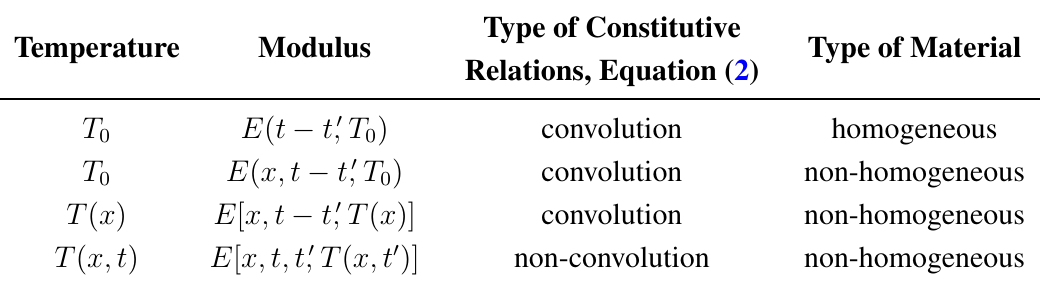
Table 1. Temperature influence on constitutive